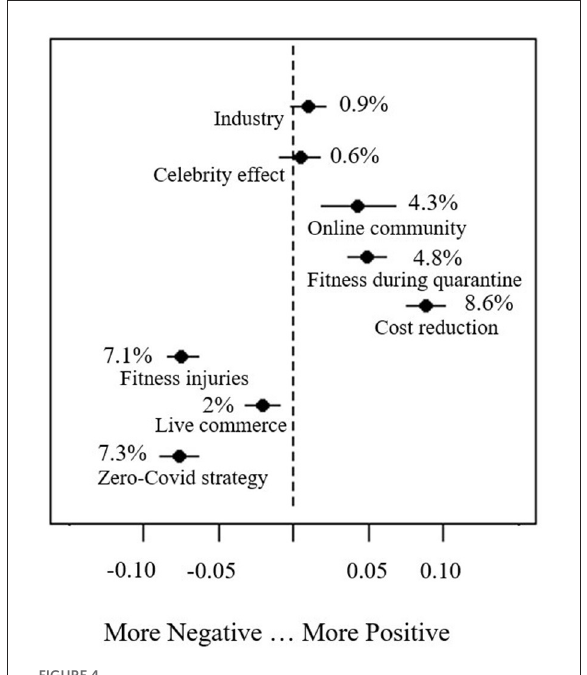
FIGURE4 Change in topic prevalence based on review extremity (positive vs.